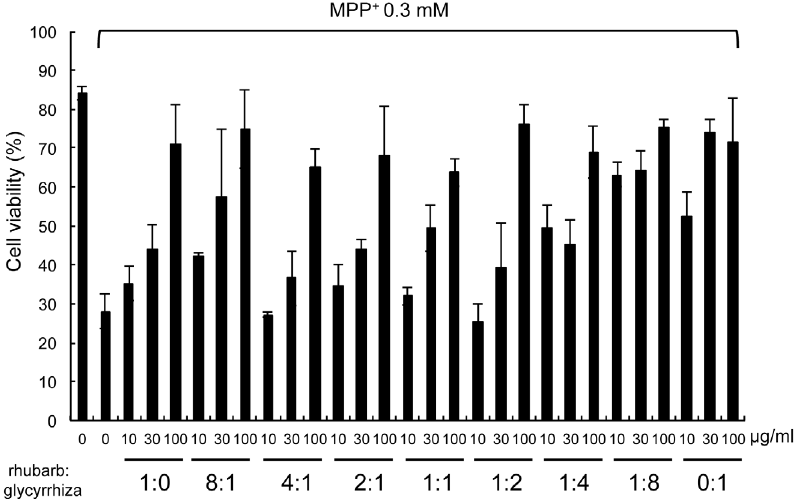
Figure 2. Glycyrrhiza prevented MPP + -induced cell death more potently than rhubarb. NGF-differentiated PC12D cells were treated with various concentrations of rhubarb and Glycyrrhiza (rhubarb: Glycyrrhiza ratio=1:0, 8:1, 4:1, 2:1, 1:1, 1:2, 1:4, 1:8, 0:1) in the presence of 0.3 mM MPP + for 48 h. Cell viability was evaluated by trypan blue exclusion assay. Values are the means of three independent experiments; bars, s.d. ** p , 0.01 compared with MPP + group cells.